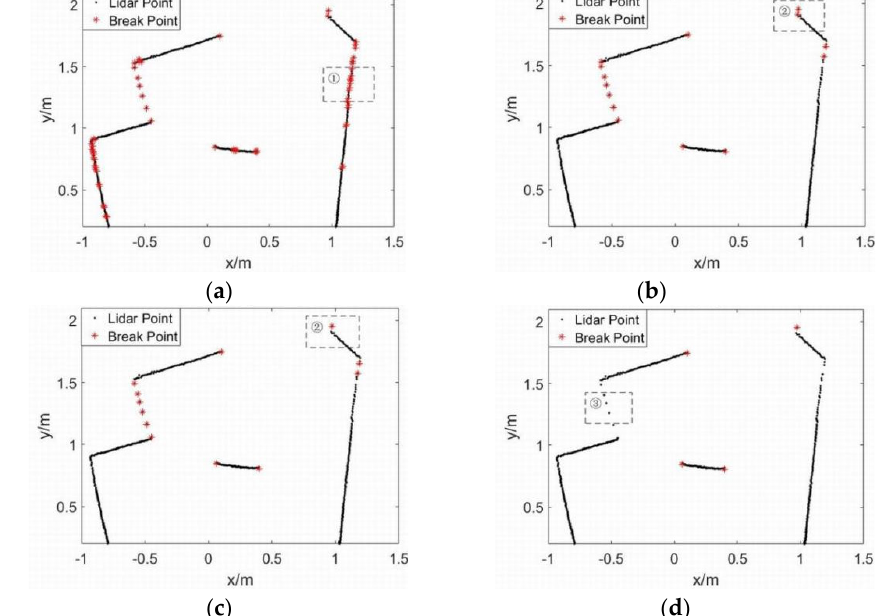
Figure 4. Comparison of breakpoint detection effect under the same 𝑘 value: ( a ) 𝑘 = 1; ( b ) 𝑘 = 3; ( c ) 𝑘 = 5; ( d ) 𝑘 = 10.